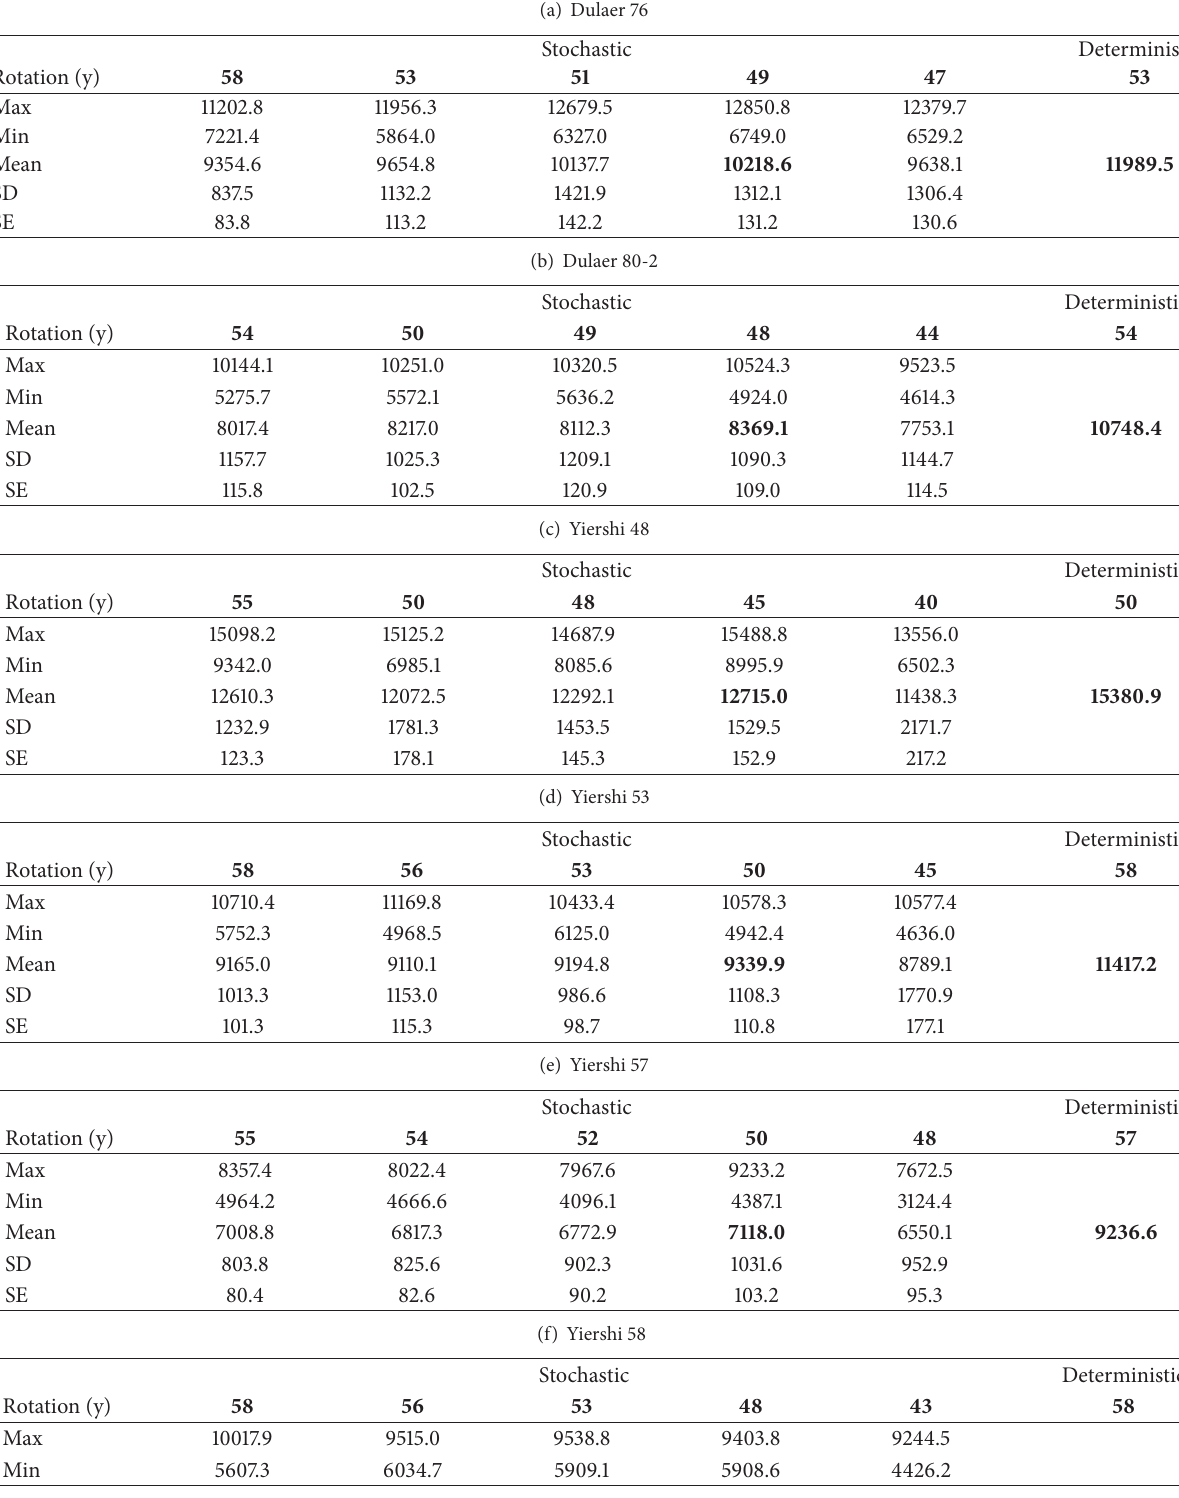
Table 2: Summary statistics of calculating 100 scenarios of the bare land value under pest risk with different rotations (bare land value, unit: $ USD/ha) and the optimal bare land value under deterministic